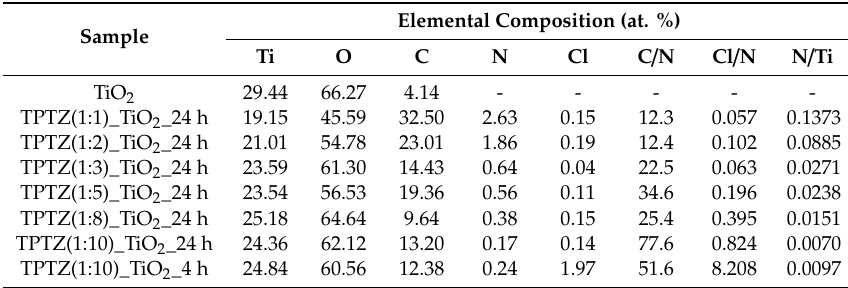
Table 3. Elemental composition (in at. %) in the surface layer of [TPTZ][Cl]-modified TiO 2 particles, evaluated by XPS analysis.